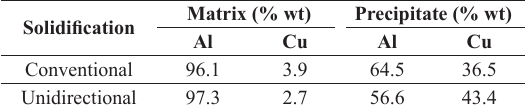
Figure 15. Grain size of the Al4.5wt%Cu alloy conventionally and unidirectionally solidified with 91% of RA and heat treatment of 450 ºC. Table 3. Quantity by weight of aluminum and copper in the Al4.5wt%Cu alloy.